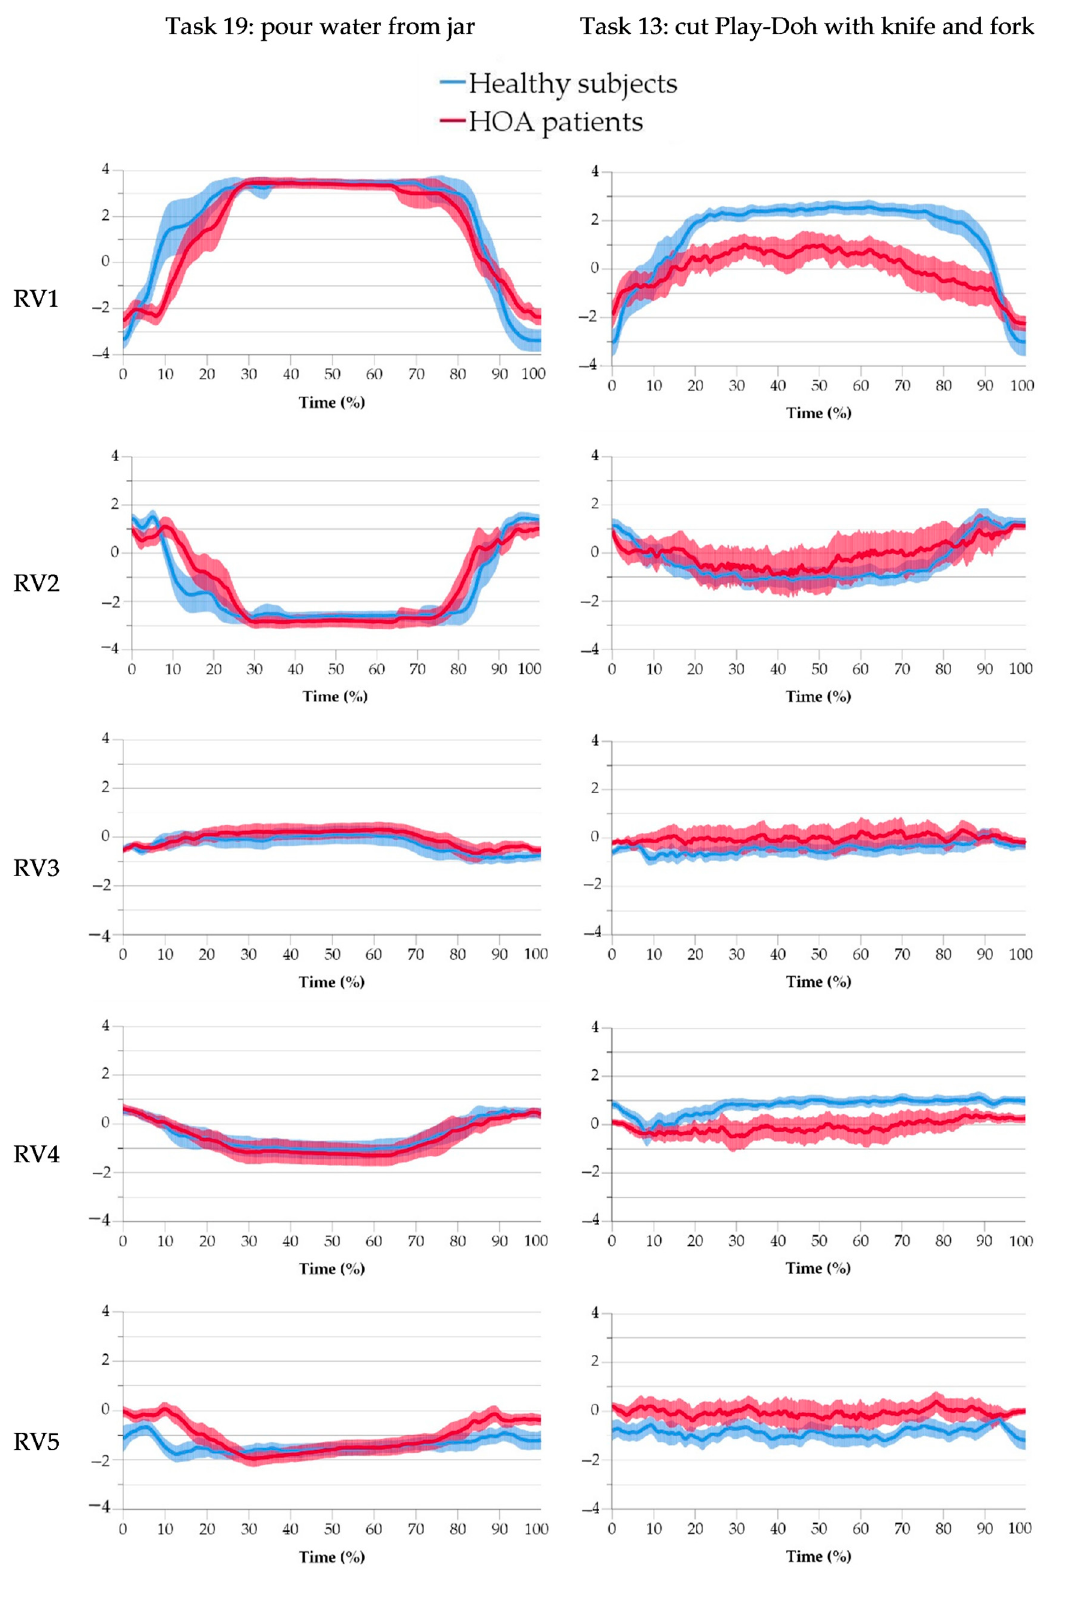
Figure 4. Temporal evolution (mean value across subjects and 95%CI) of RVs in task 19 (pour water from a jar) and task 13 (cut Play Doh with a knife and fork) for healthy subjects (blue) and HOA patients (red).